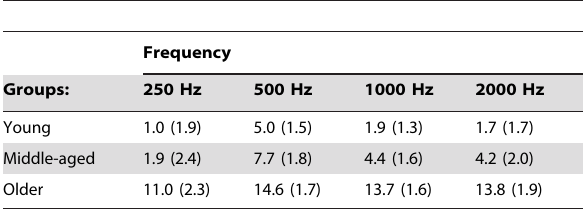
Table 2. Group mean audiometric (HL) threshold (and standard error) in young, middle-aged, and older adults averaged over the left and right